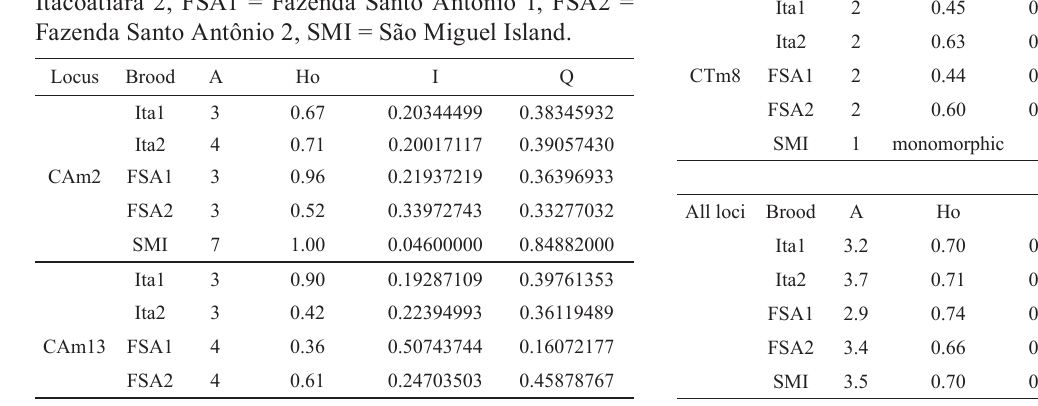
Table 1. Main genetic pattern for each loci analysed in each brood of Arapaima gigas . A = number of alleles, Ho = observed heterozygosity, I = probability of genetic identity, Q = probability of paternity exclusion, IC = Joint probability of genetic identity at all loci , QC = Joint probability of paternal exclusion at all loci . Ita1 = Itacoatiara 1, Ita2